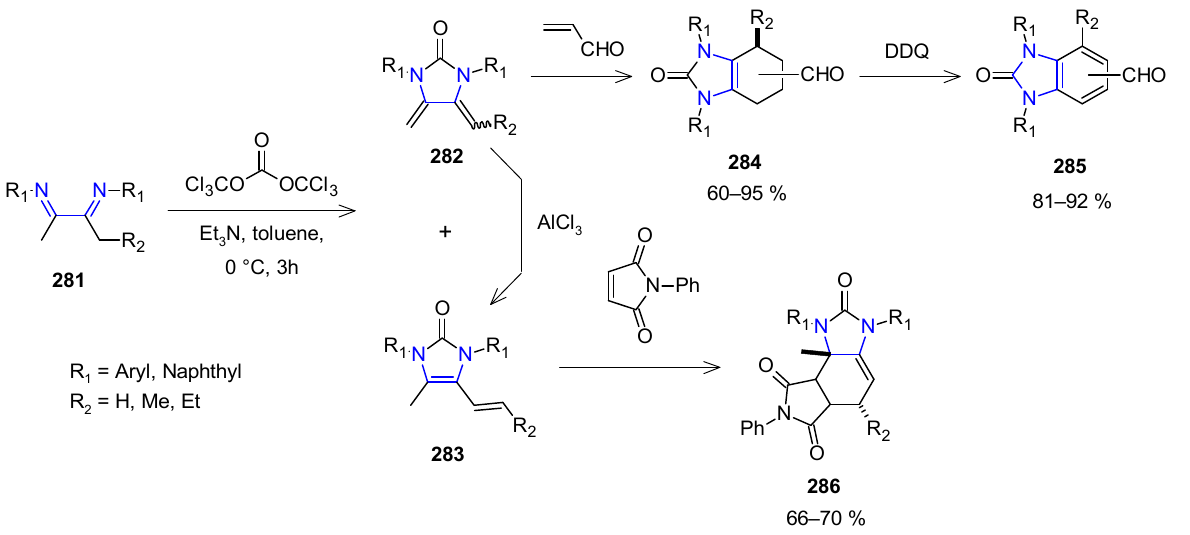
Scheme 67. Synthesis of N , N -disubstituted exo-2-imidazolidinone dienes 282 and cycloaddition reactions.